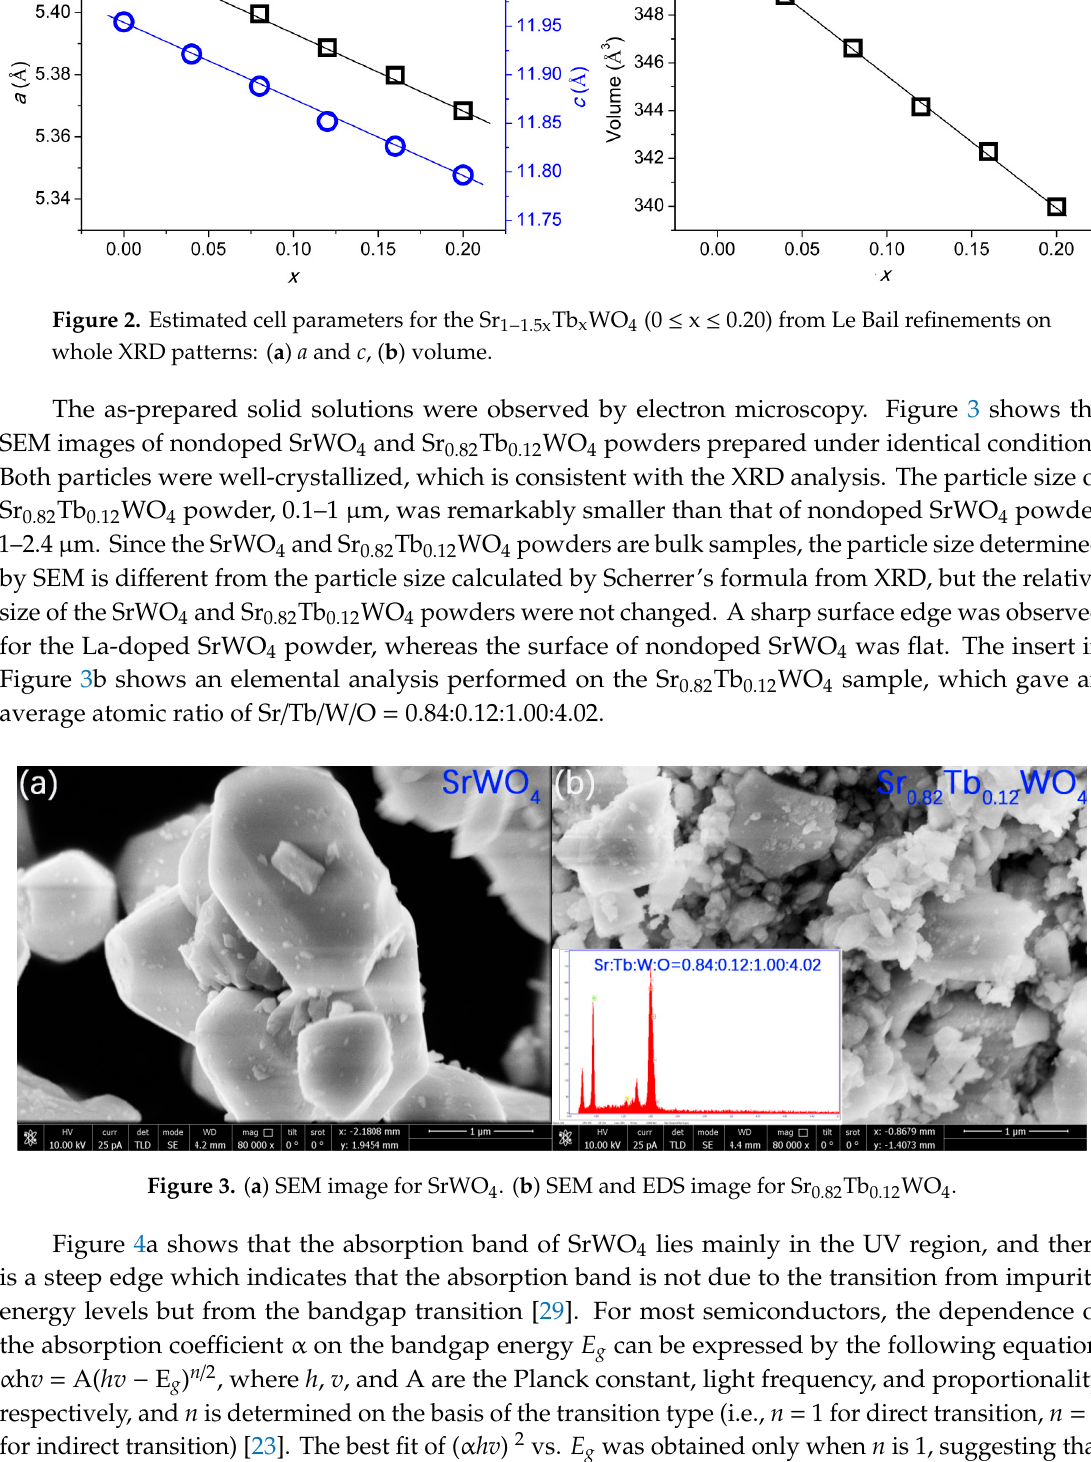
Figure 3. ( a ) SEM image for SrWO 4 . ( b ) SEM and EDS image for Sr 0.82 Tb 0.12 WO 4 .